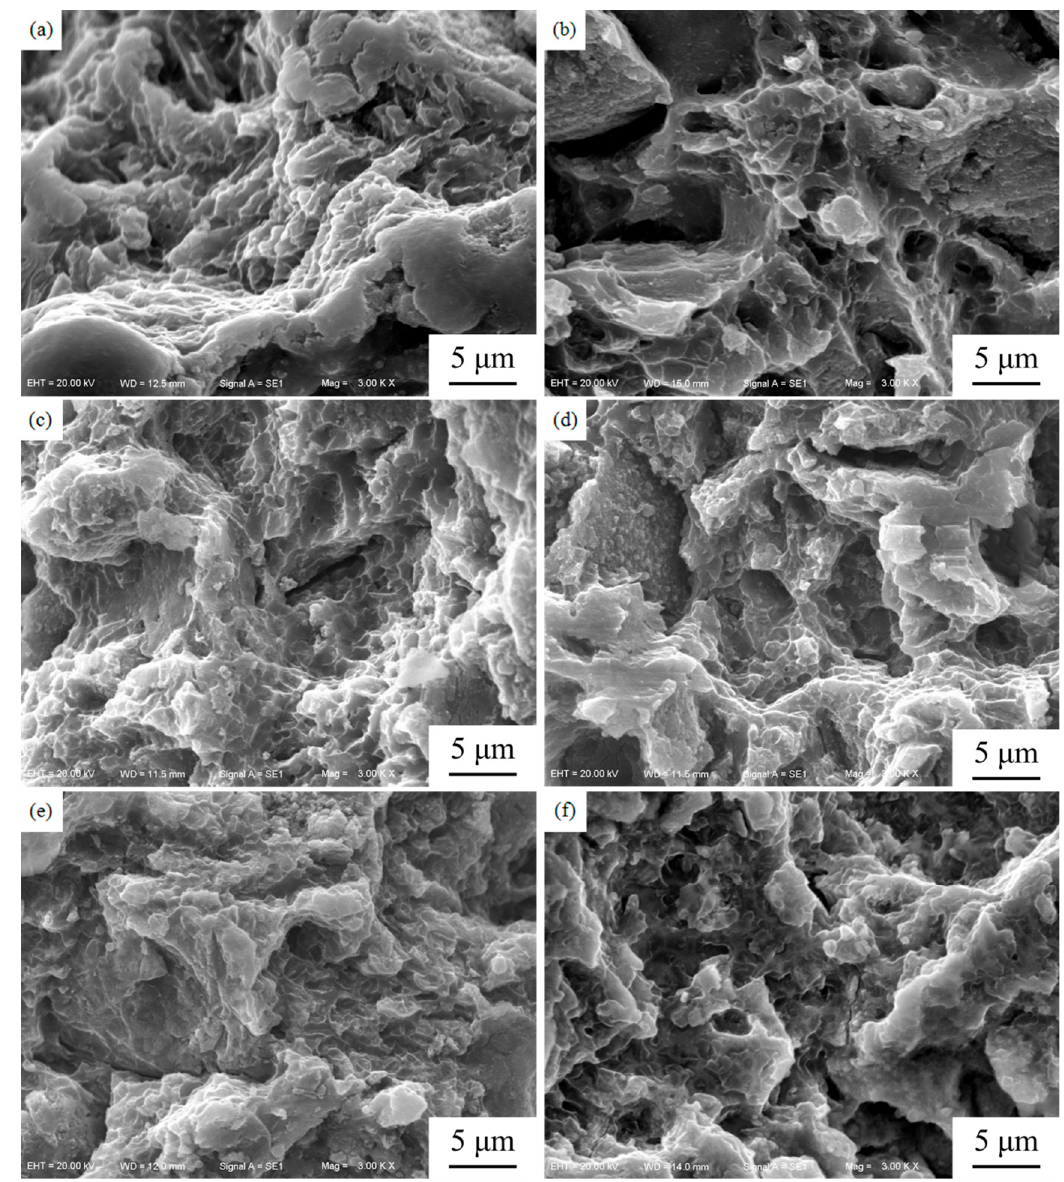
Figure 11. Compressive fracture morphologies of the LAMed porous Mg-Zn-Zr alloys. ( a , c , e ) E1, E1 and E3 (the horizontal compression), ( b , d , f ) E1, E2 and E3 (the longitudinal compression).